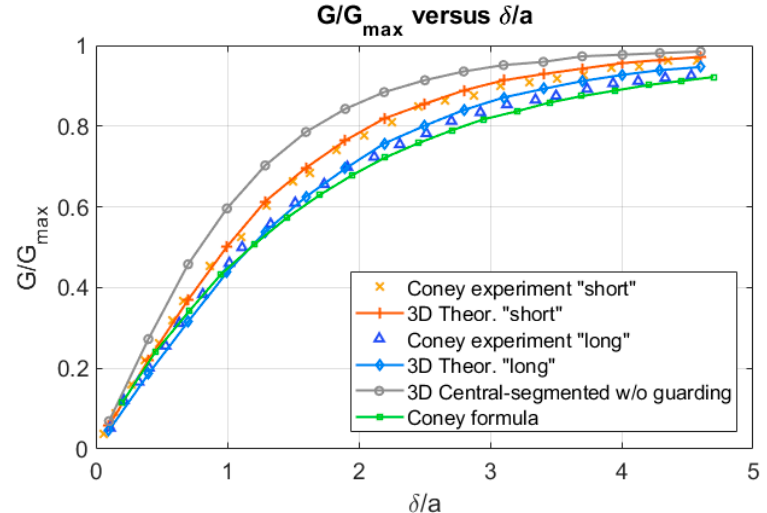
Figure 8. (cid:1833)/(cid:1833) (cid:3040)(cid:3028)(cid:3051) versus (cid:2012)/(cid:1853) , for different cases explained in the text. The upper curve grey line has Figure 8. G / G max versus δ / a , for di ff erent cases explained in the text. The upper curve grey line been computed with Equation (19) for G/Gmax and (cid:1864) = 2.88 mm , the lower green line has been has been computed with Equation (19) for G / Gmax and l = 2.88 mm, the lower green line has been computed with the Coney formula which assumes (cid:1864) ≫ (cid:1853). computed with the Coney formula which assumes l (cid:29) a